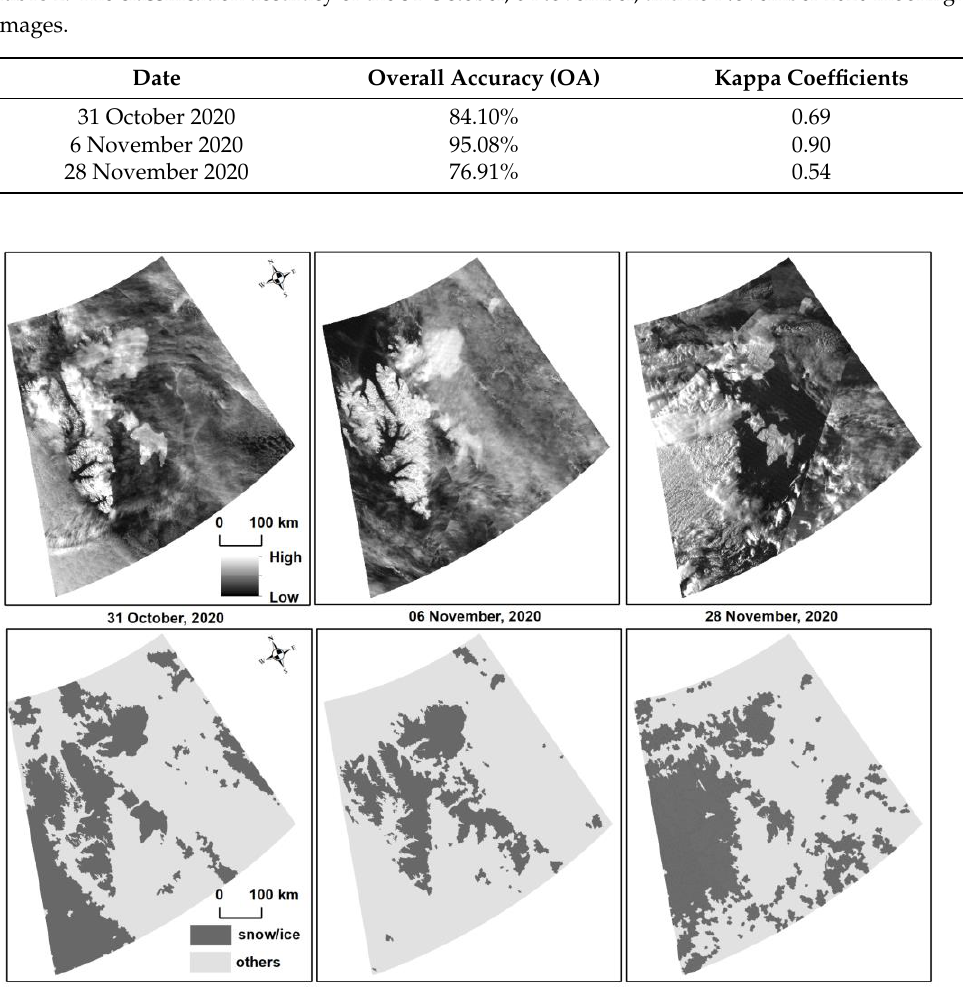
Figure 13. The potential of moonlight remote sensing for monitoring intra-month polar snow/ice changes. Table 2. The classification accuracy of the 31 October, 6 November, and 28 November 2020 moon- light images.